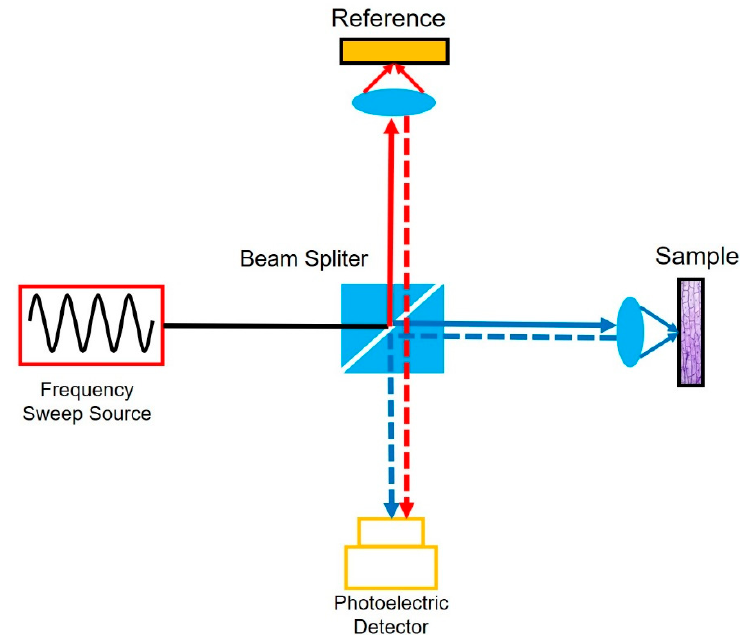
Figure 16. The principle of swept-source OCT.